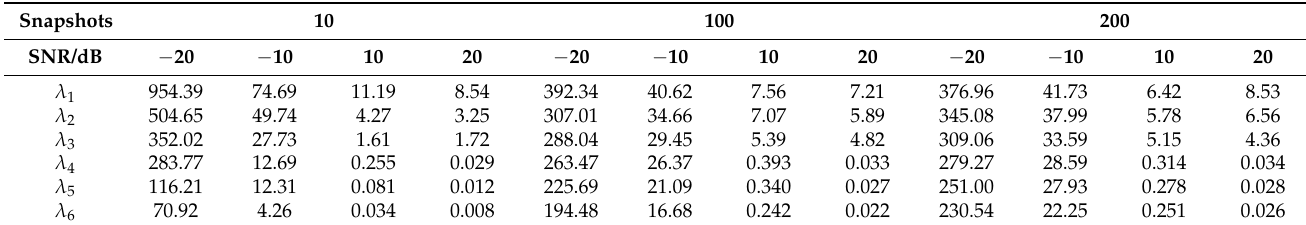
Table 1. Eigenvalues at different snapshots and SNR.